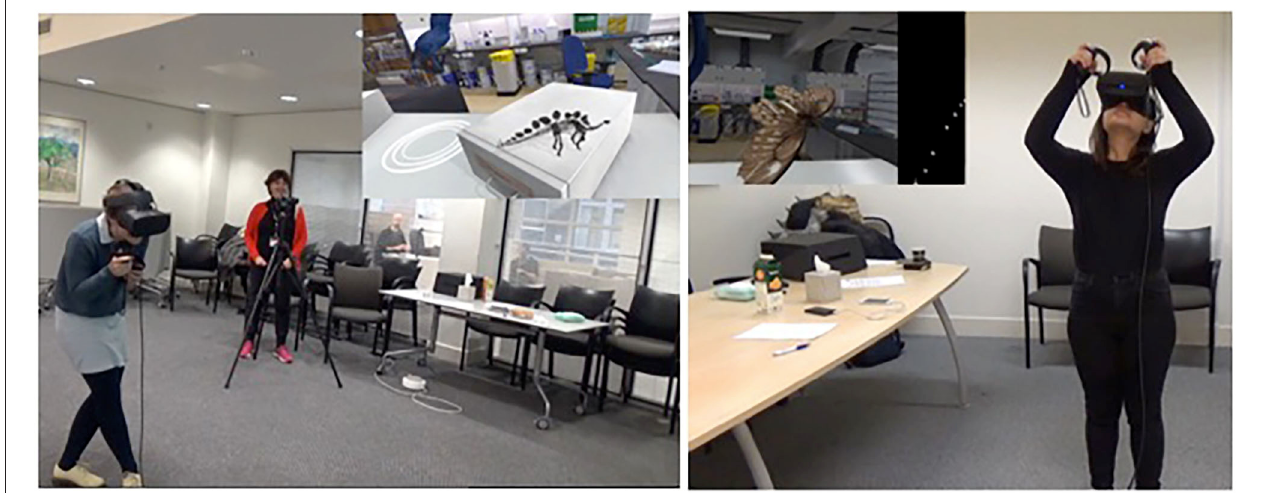
FIGURE 8 | Engaging the body to take a closer look – leaning in/peering underneath – at the dinosaur and butterfly.